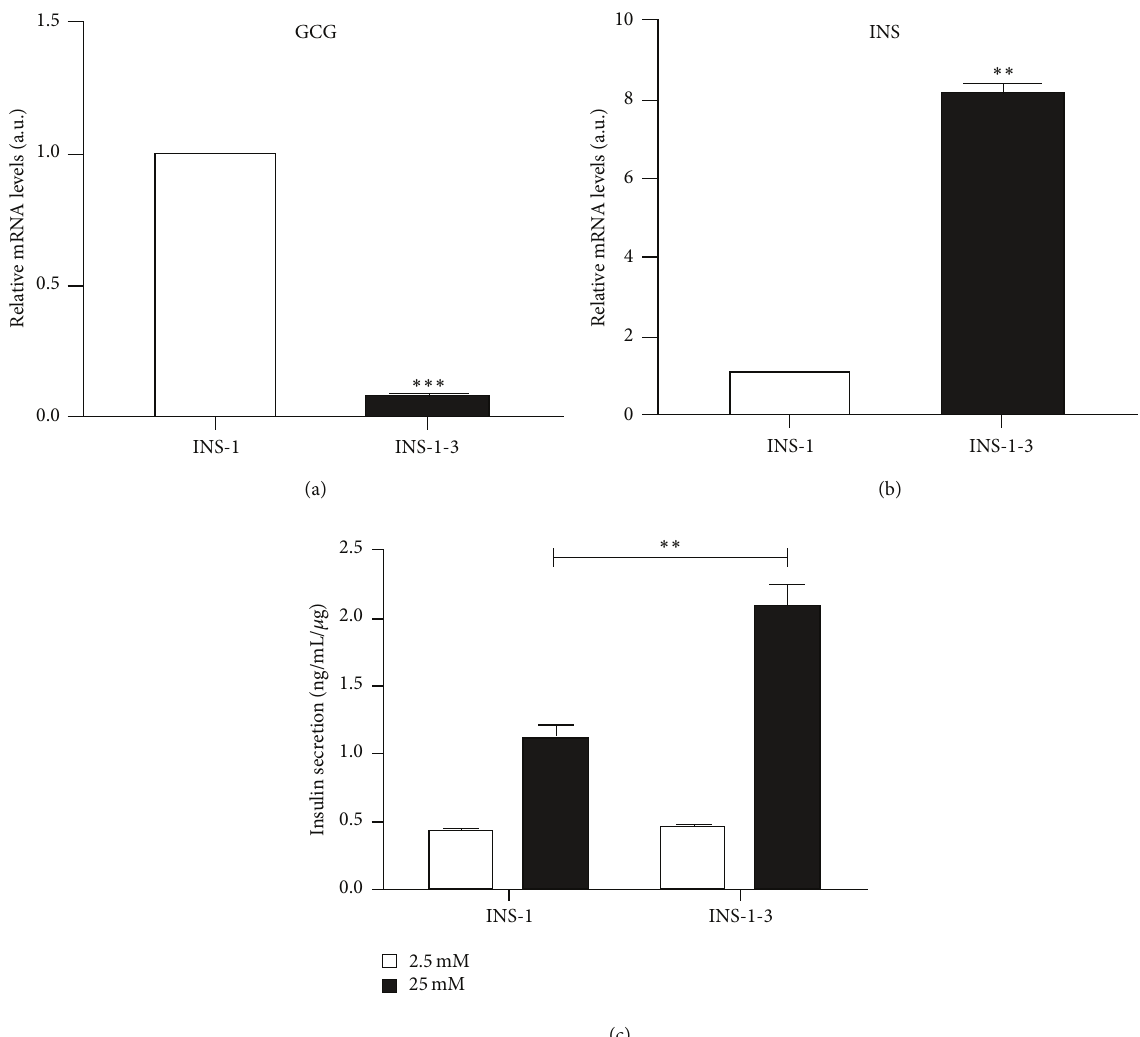
Figure 1: The insulin expression and secretion in INS-1-3. (a) The mRNA level of glucagon was compared between INS-1-3 and INS-1 cells, by real-time PCR. (b) The mRNA level of insulin was compared between INS-1-3 and INS-1 cells. The 𝛽 -actin mRNA level was used as control. (c) Insulin secretion from INS-1-3 and INS-1 cells in response to 2.5 mM and 25 mM glucose, normalized to the total insulin content, measured by ELISA. Data are derived from three independent experiments and shown as mean ± SD. ∗∗ 𝑝 < 0.01 ; ∗∗∗ 𝑝 < 0.001 versus